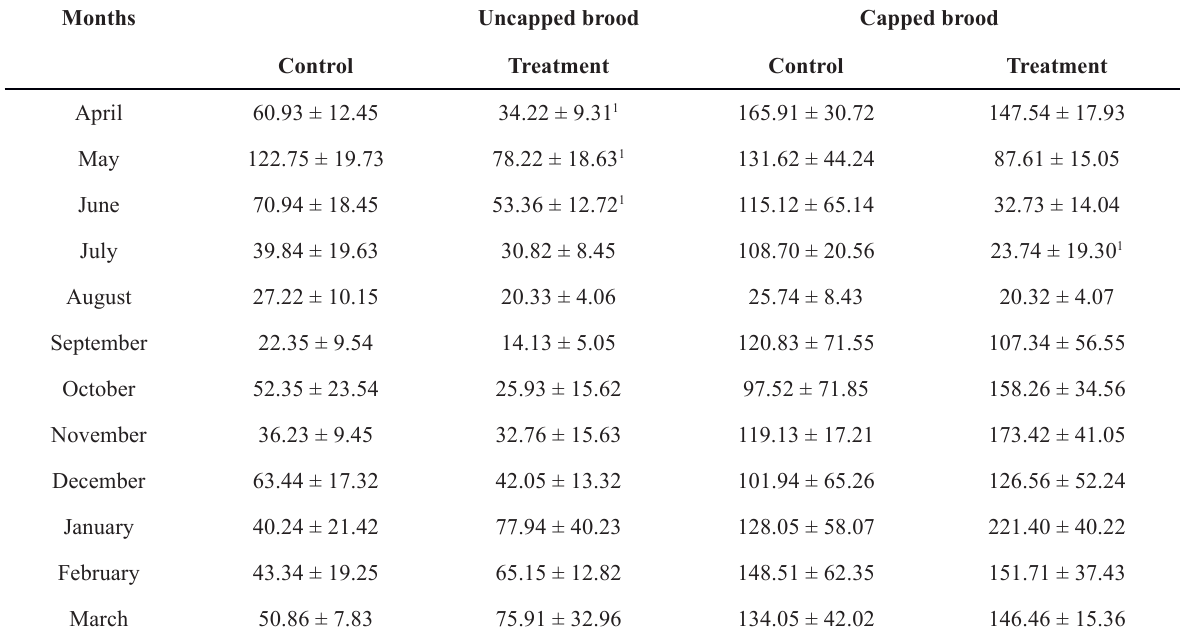
Table 1. Means and standard deviations of the uncapped and capped brood areas (cm 2 ) of African-derived Apis mellifera (L.) colonies without (Control) and with the harvest of apitoxin (Treatment), between April 2013 to March 2014.